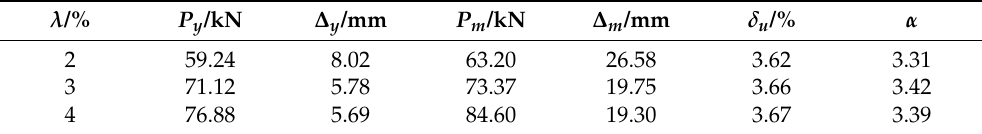
Figure 9. Hysteresis skeleton curve. Table 5. Characteristic points of skeleton curve of test piece.